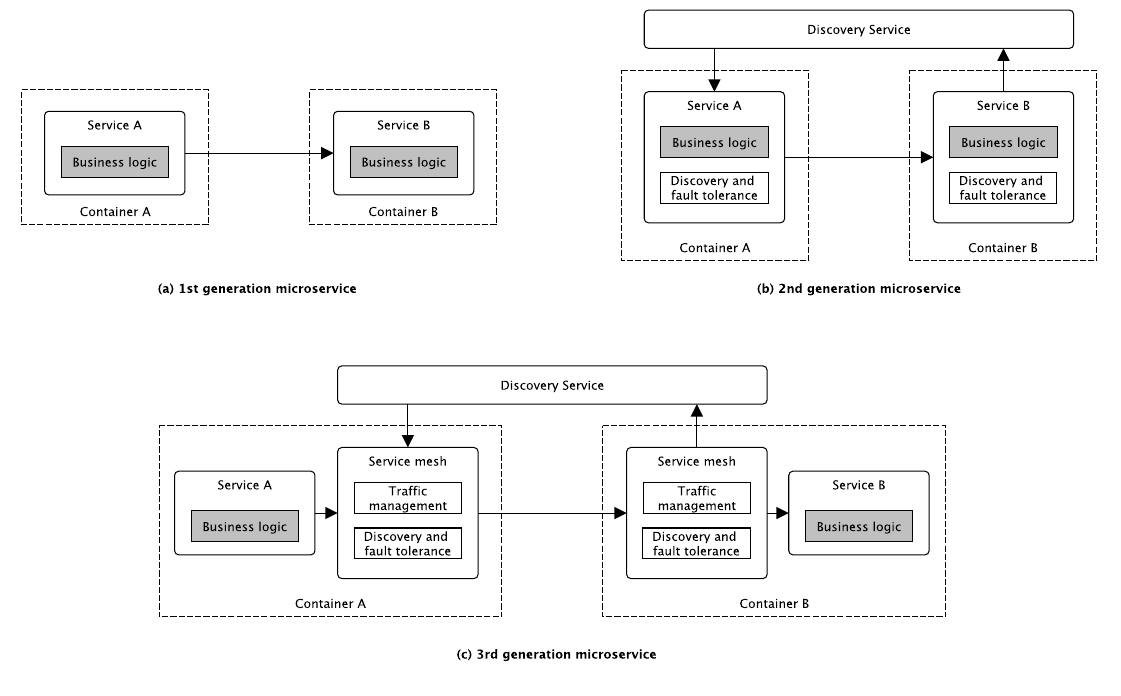
Figure 7. Microservice architecture evolution—adapted from